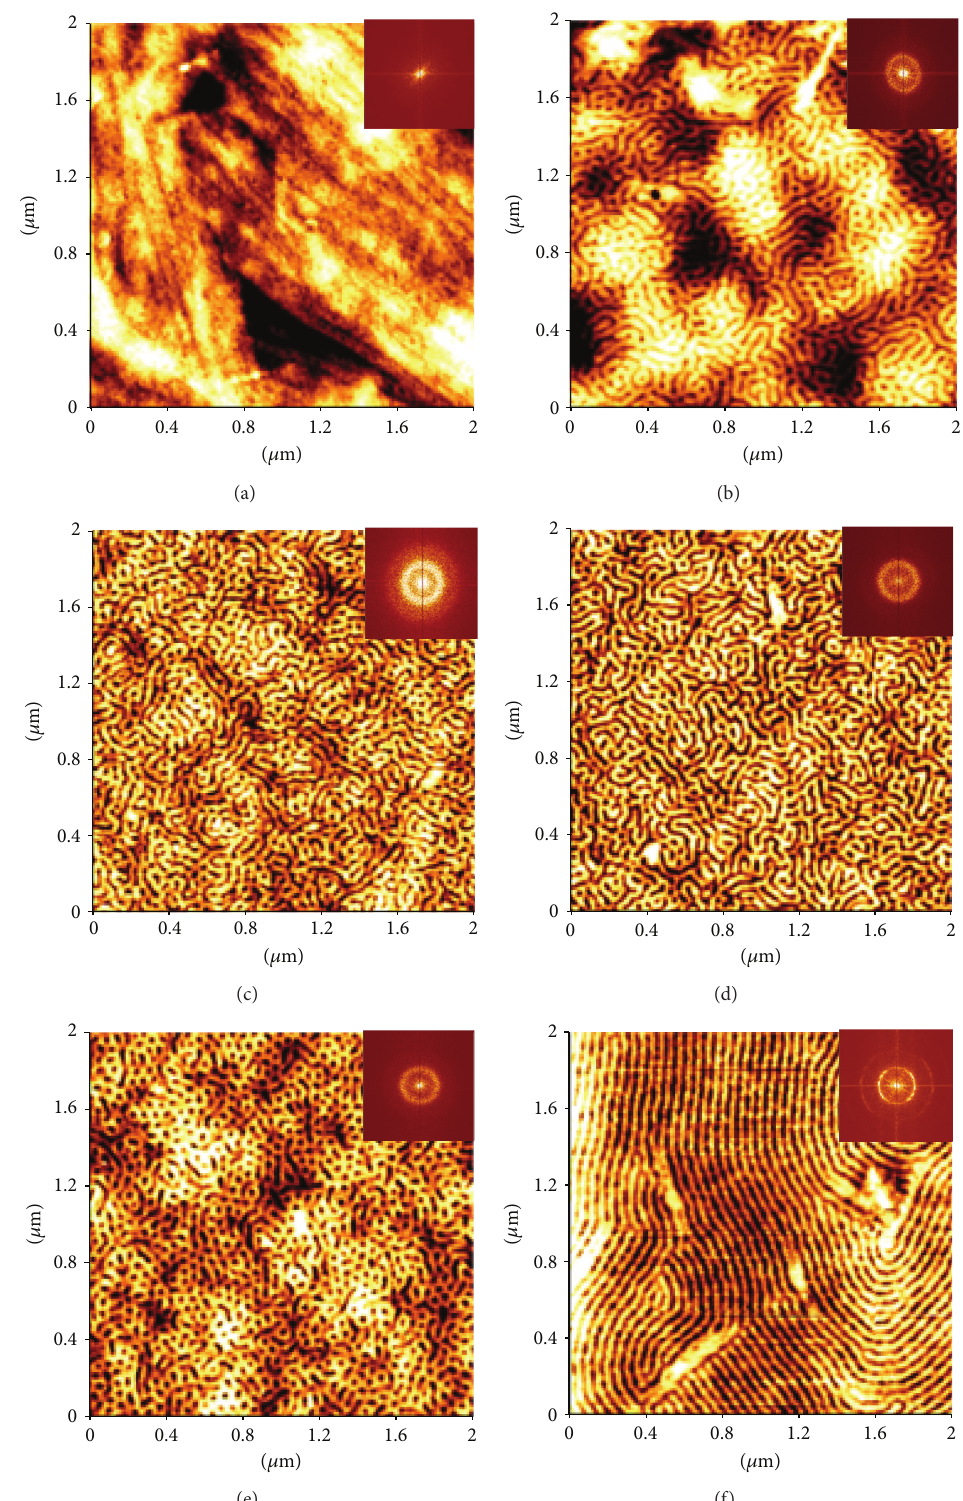
Figure 2: AFM topography images of PS- b -PFS thin films on Si substrates prepared from 1.0wt.% solution of the polymer in toluene after 3 h exposure to (a) toluene, (b) acetone, (c) hexane, (d) heptane, (e) cyclohexane, and (f) THF atmospheres at room